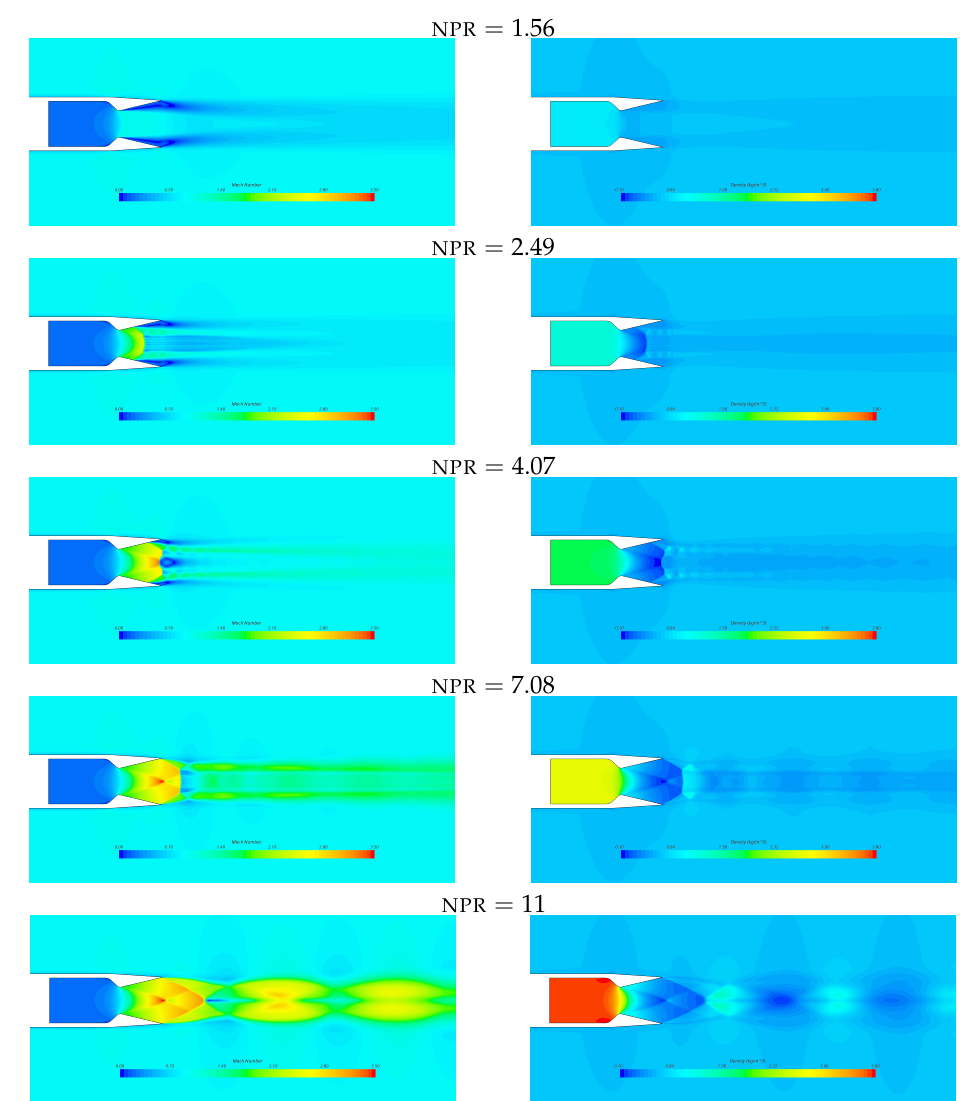
Figure 7. Mach number ( left ) and density ( right ) fields for different NPR ’s and M ∞ =